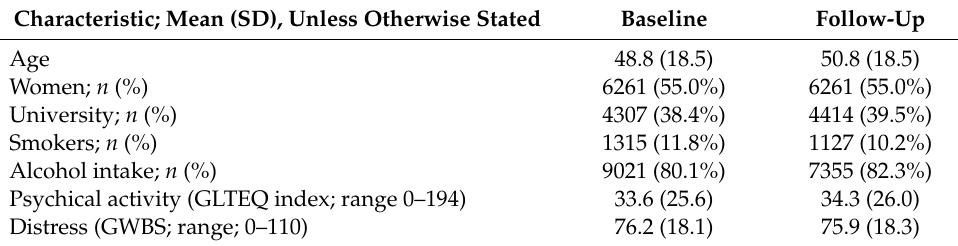
Table 1. Population characteristics at baseline and two-year follow-up.